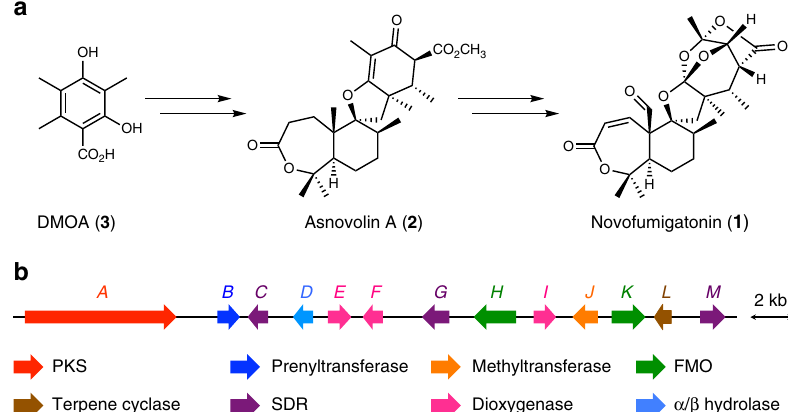
Fig. 1 Novofumigatonin and its biosynthetic gene cluster. a Structures of novofumigatonin ( 1 ) and its predicted biosynthetic precursors. b Schematic representation of the nvf cluster and predicted function of each gene based on BLASTP comparison with characterized proteins. PKS polyketide synthase, FMO fl avin-dependent monooxygenase, SDR short-chain dehydrogenase/reductase NATURE COMMUNICATIONS| (2018) 9:2587 |DOI: